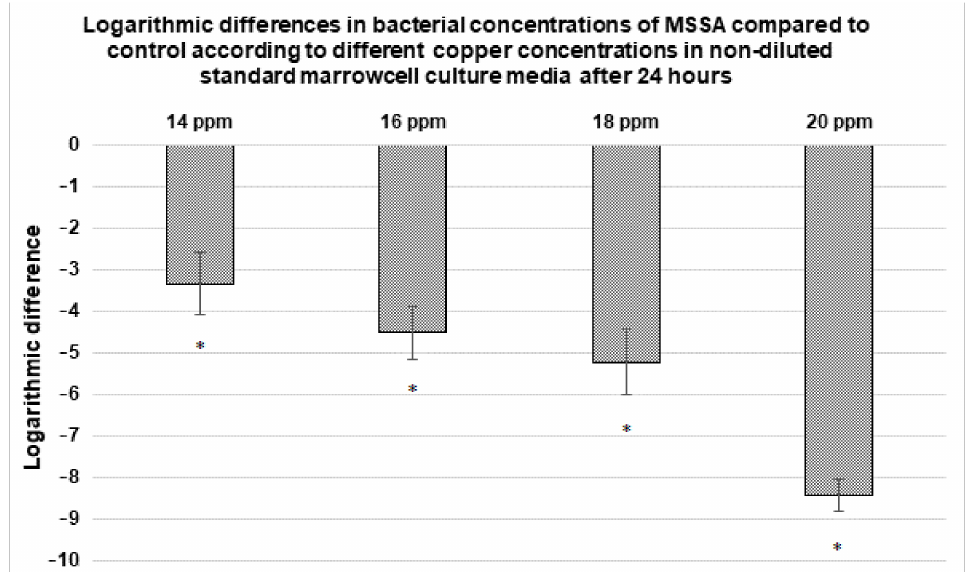
Figure 7. Variation in the bacterial concentration of MSSA with respect to different copper concentrations in a non-diluted standard marrow cell culture medium after 24 h. Copper concentrations below 14 ppm showed results similar to the control (0 ppm); therefore, bacterial concentrations values are not presented here. Results statistically different compared to the control (with p < 0.05) are indicated by